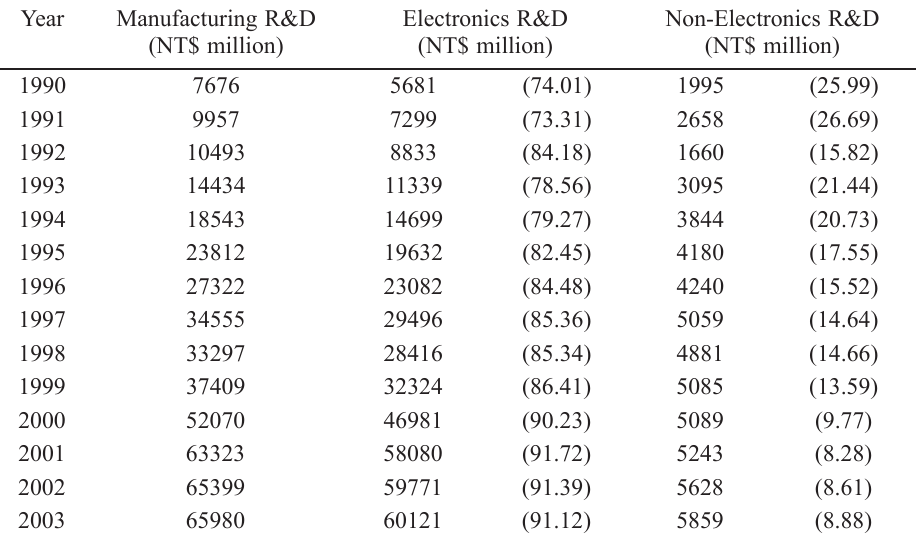
Table 3. The distribution of the total amount of R&D, year by